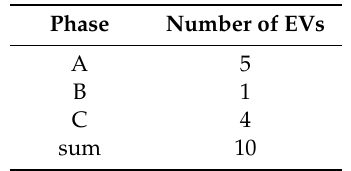
Table 2. EV connection by phase.